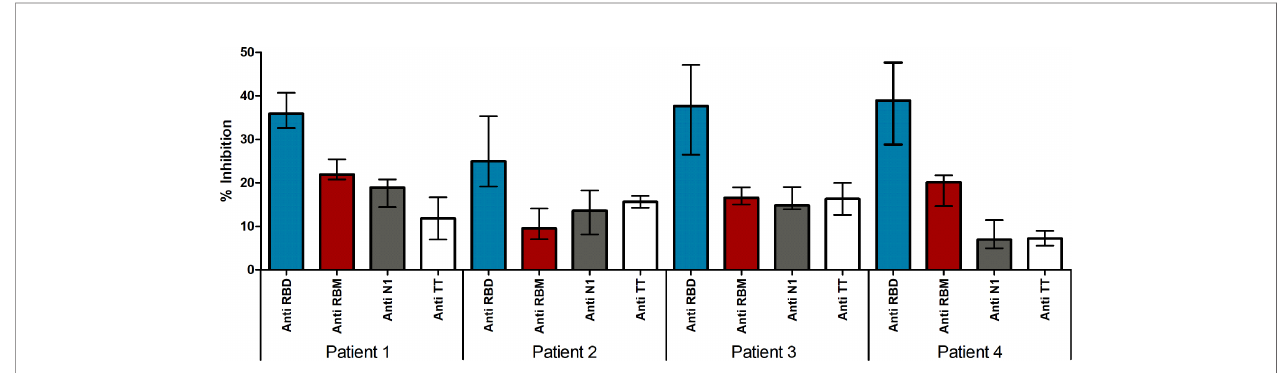
FIGURE 9 | Neutralizing ability of antibodies in Covid-19 patients. Neutralizing ability of antigen eluted anti-S, anti-RBD and anti-RBM antibodies in COVID-19 patients. Results are shown as the percentage of inhibition of ACE-HRP binding to RBD.